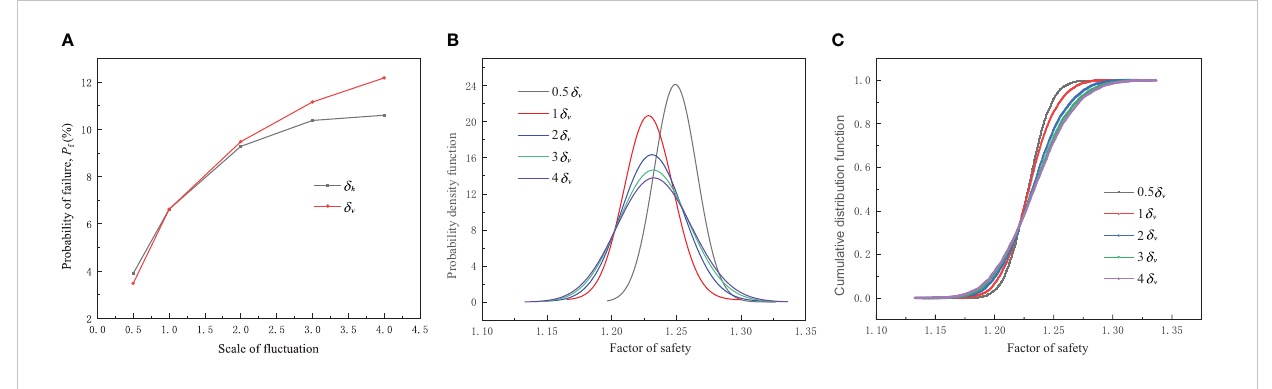
FIGURE 12 The effect of the fl uctuation: (A) In fl uence of different fl uctuation coef fi cients on failure probability; (B) probability density function; (C) probability distribution of the FOS.